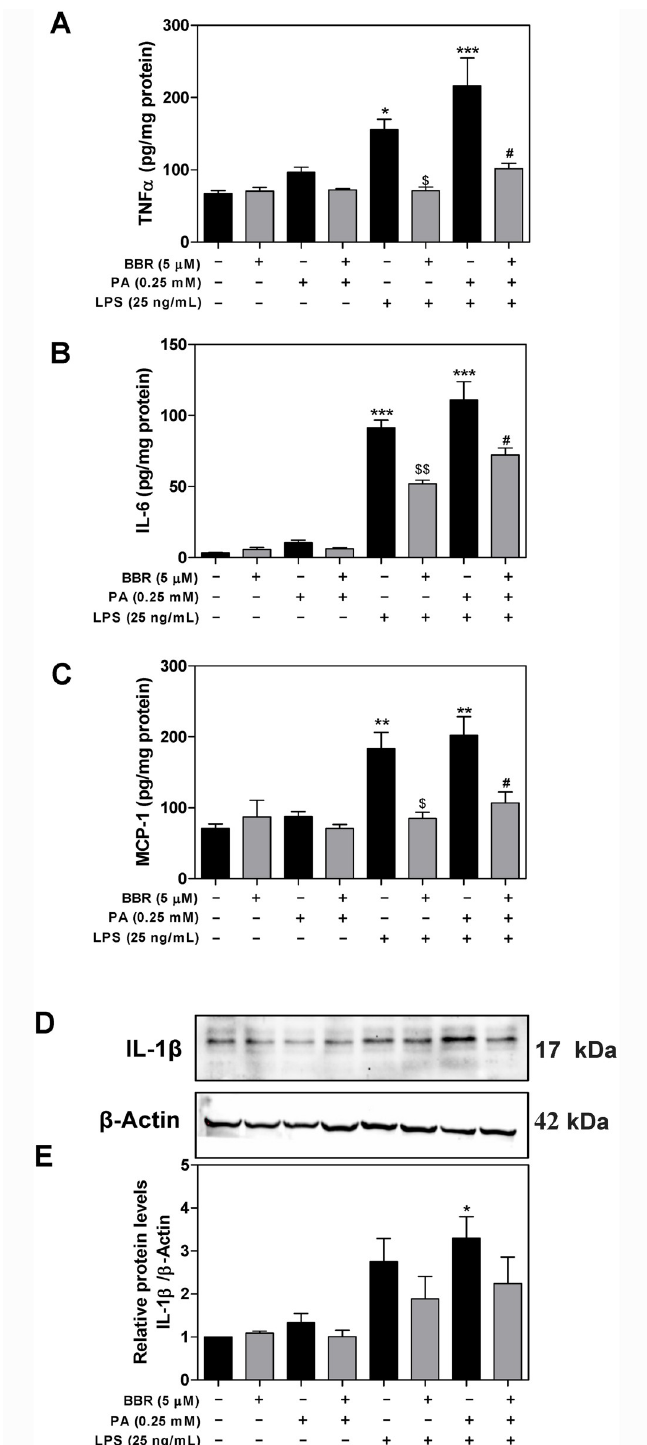
Fig 2. Effect of BBR on PA and LPS-induced protein expression of proinflammatory mediators in RAW264.7 cells. RAW264.7 cells were pretreated with BBR (5 μ M) for 1 h, then treated with PA (0.25mM) or LPS (25 ng/mL) or both for 6 h. At the end of treatment, cell culture medium and total cell lysates were collected. The protein levels of TNF- α , IL-6, and MCP-1 were determined by ELISA as described under Materials and Methods. Relative protein levels of TNF- α , IL-6, and MCP-1 were normalized by total protein amounts and expressed as pg/mg of protein. The